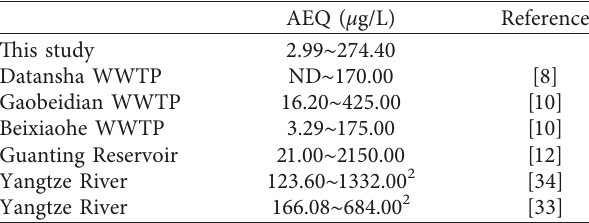
Table 3: Analysis of TR antagonist activities using recombinant yeast assay in an aquifer in